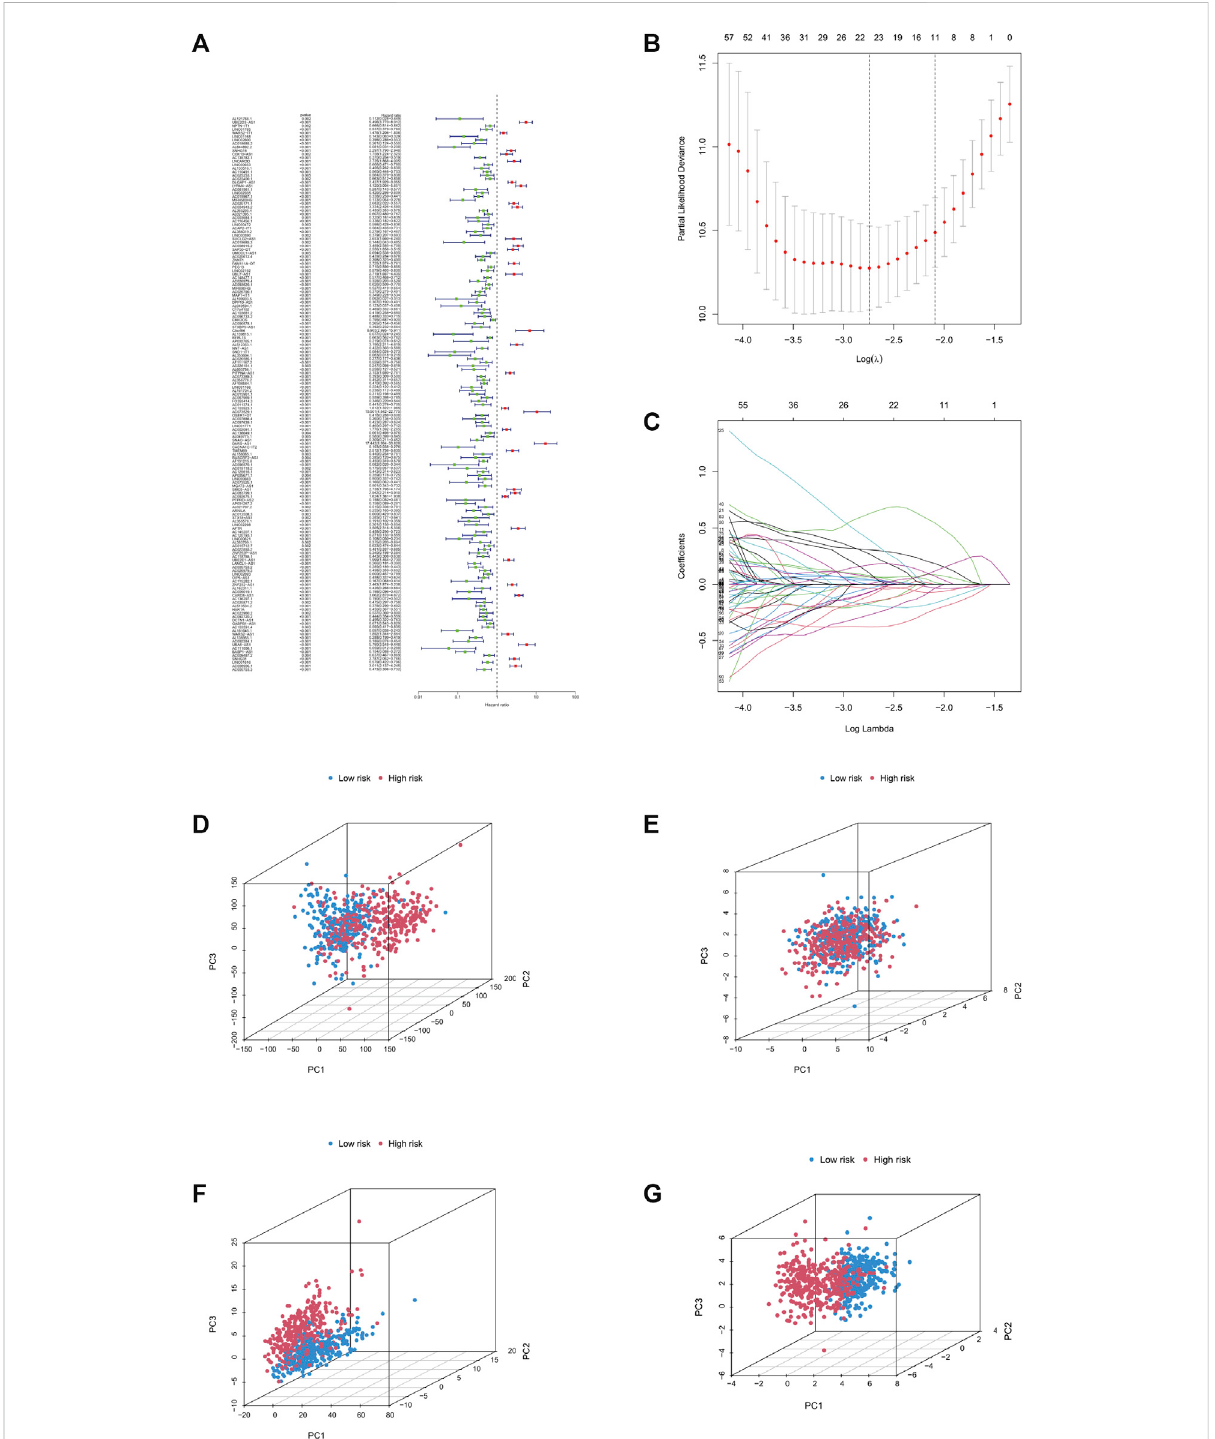
FIGURE 1 Construction of prognostic models. (A) Forest plot, green for low risk lncRNAs, red for high risk lncRNAs. (B) Lasso regression graph. (C) Cross- validated graph. (D) Graph of all genes. (E) Graph of copper death-associated genes. (F) Copper death-associated lncRNA model. (G) Model lncRNA model. Abbreviation: lnc RNAs, Long non-coding